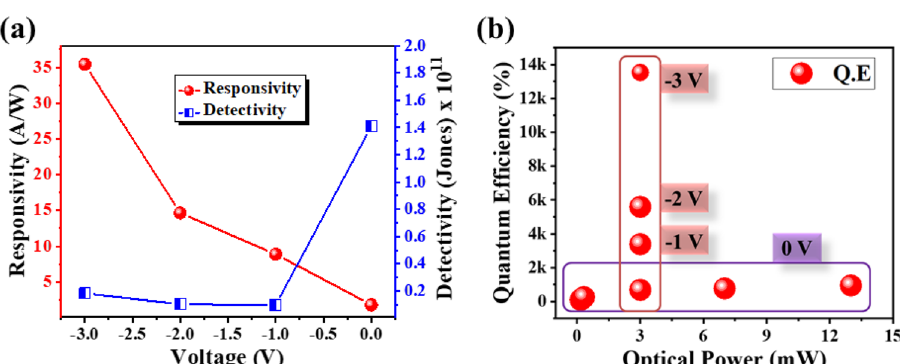
Figure 7. ( a ) Responsivity and detectivity graph w.r.t applied bias, ( b ) QE of fabricated GaN-NTs UV-PD w.r.t incident optical power and applied